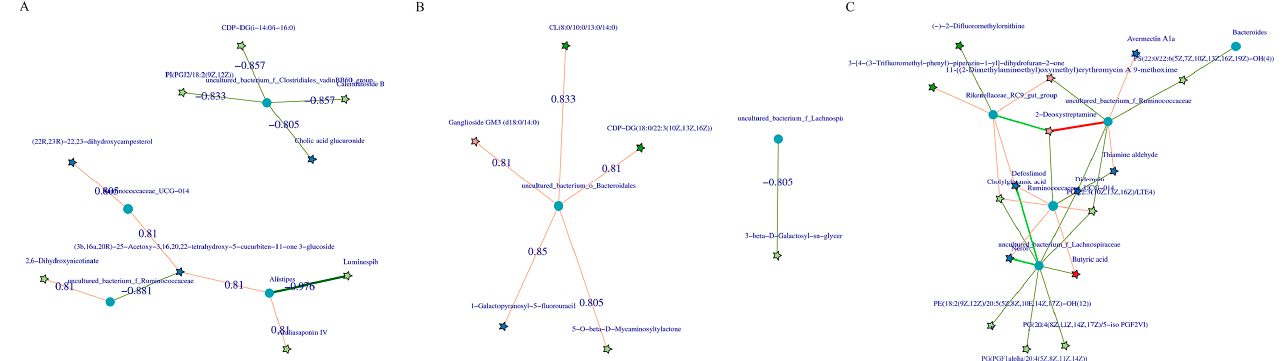
Figure 7. Correlation network diagram of the top 20 significant microbe–metabolite pairs. Pentagrams represent metabolites and circles represent microbes. The red line represents a positive correlation, the green line represents a negative correlation, and the wider the line, the higher the correlation, ( A ) correlation network diagram of all metabolites with all microorganisms (d27 vs. d53), ( B ) d105 vs. d133, ( C ) d133 vs. d161. d027, n = 5; d053, n = 5; d0105, n = 5; d133, n = 5; d161, n = 5.